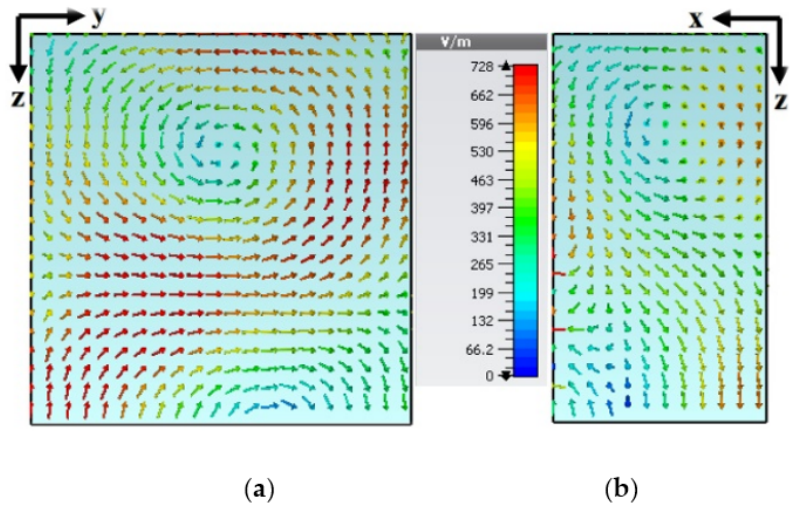
Figure 9. Electric fields: ( a ) TEx δ 13 at 3.74 GH and ( b ) TEy1 δ 3 at 4.4 GHz.